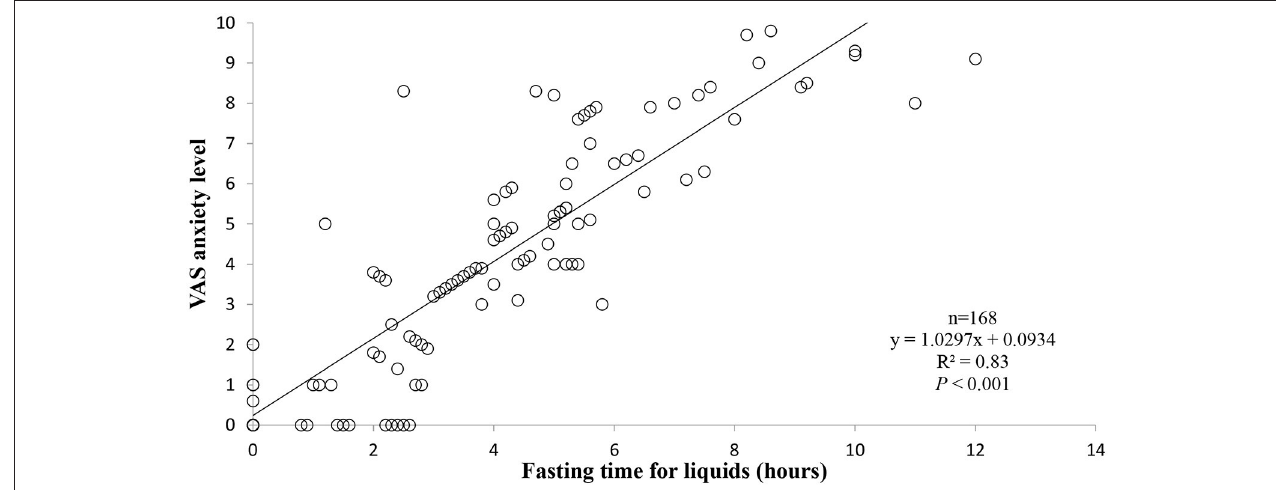
FIGURE 1 | Correlations between anxiety level and fasting time for